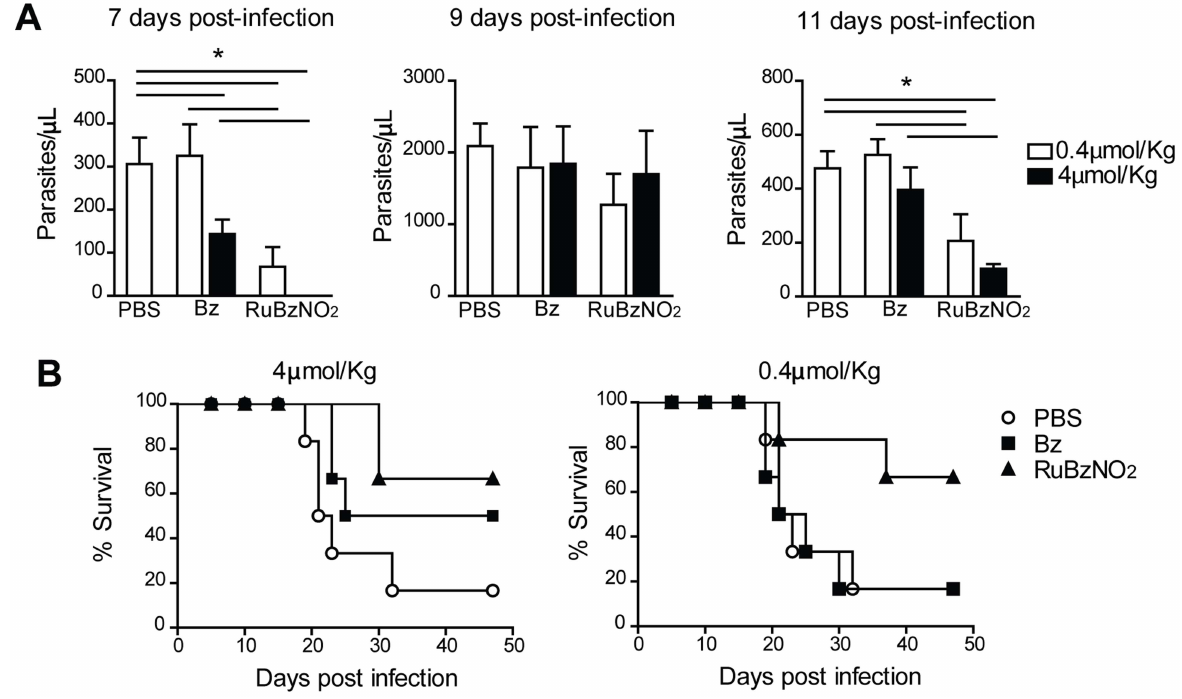
Figure 4. Treatment with RuBzNO 2 reduces parasitemia and improves the survival of T.cruzi -infected mice. Mice were infected with 2000 trypomastigotes of T. cruzi and treated orally for 10 days from the first day of patent parasitemia (5 days post-infection) with 4 m mol/kg or 0.4 m mol/kg of Bz or RuBzNO 2 . A. Parasitemia was evaluated in the blood by counting parasites with an optical microscope. B. Survival was monitored daily. The bars indicate means + SEM of 6–7 mice/experiment and are representative of three independent experiments. * represents p , 0.05.